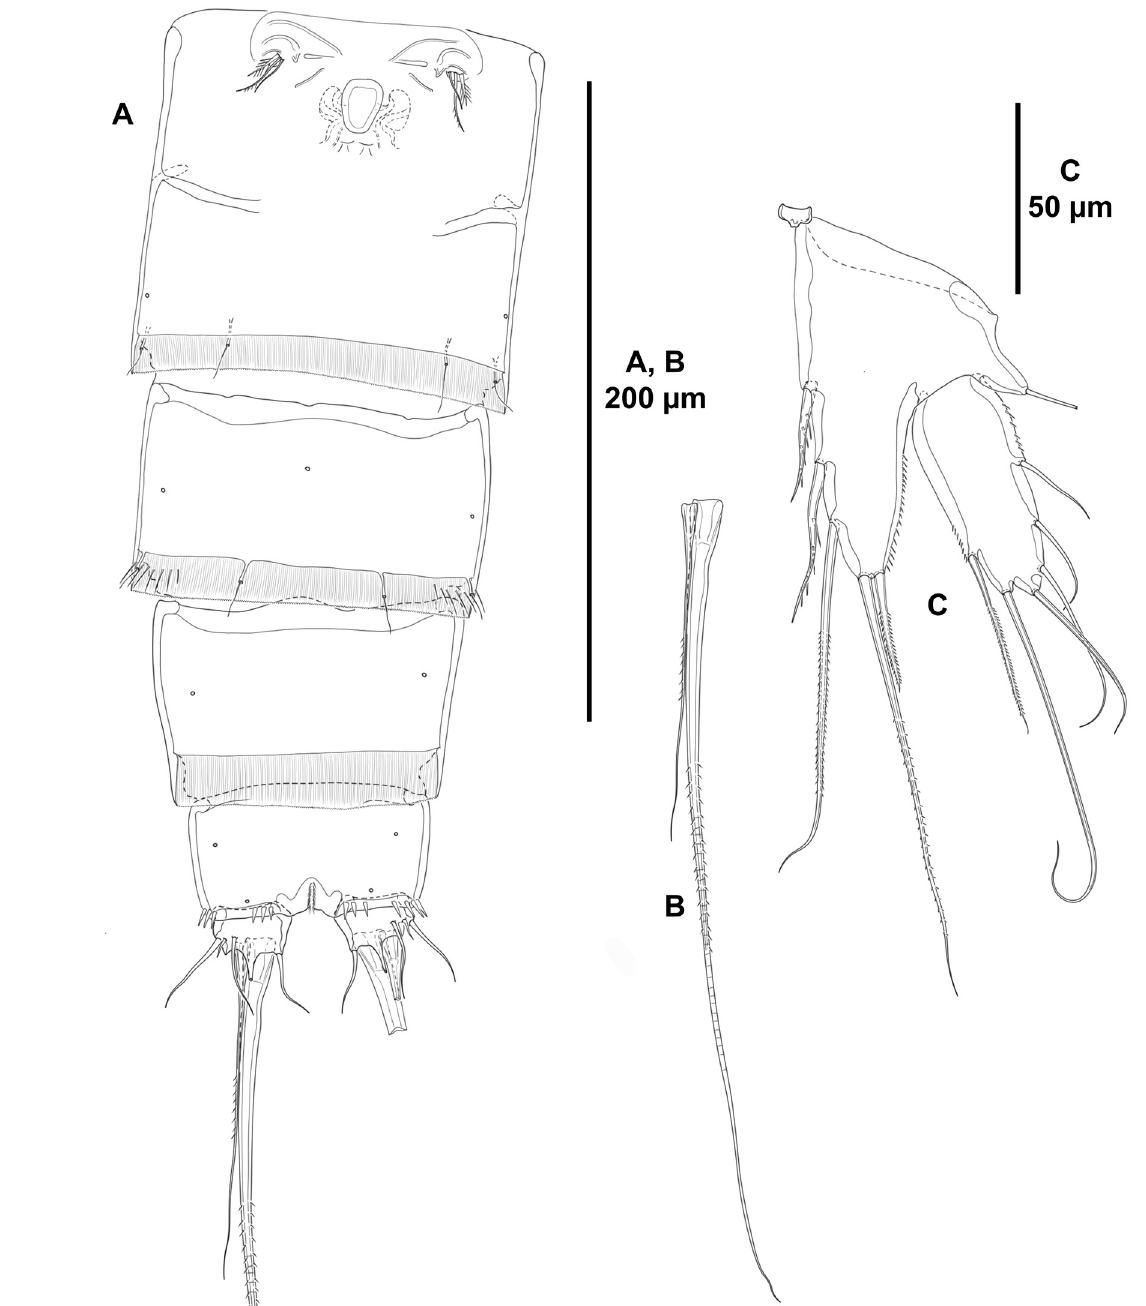
Fig. 12. Spinodiosaccus primus gen. et sp. nov., paratype, ♀ (ICML-EMUCOP-180119-64). A . Urosome, ventral view (P5-bearing somite omitted). B . Caudal setae IV and V, ventral view. C . P5, anterior